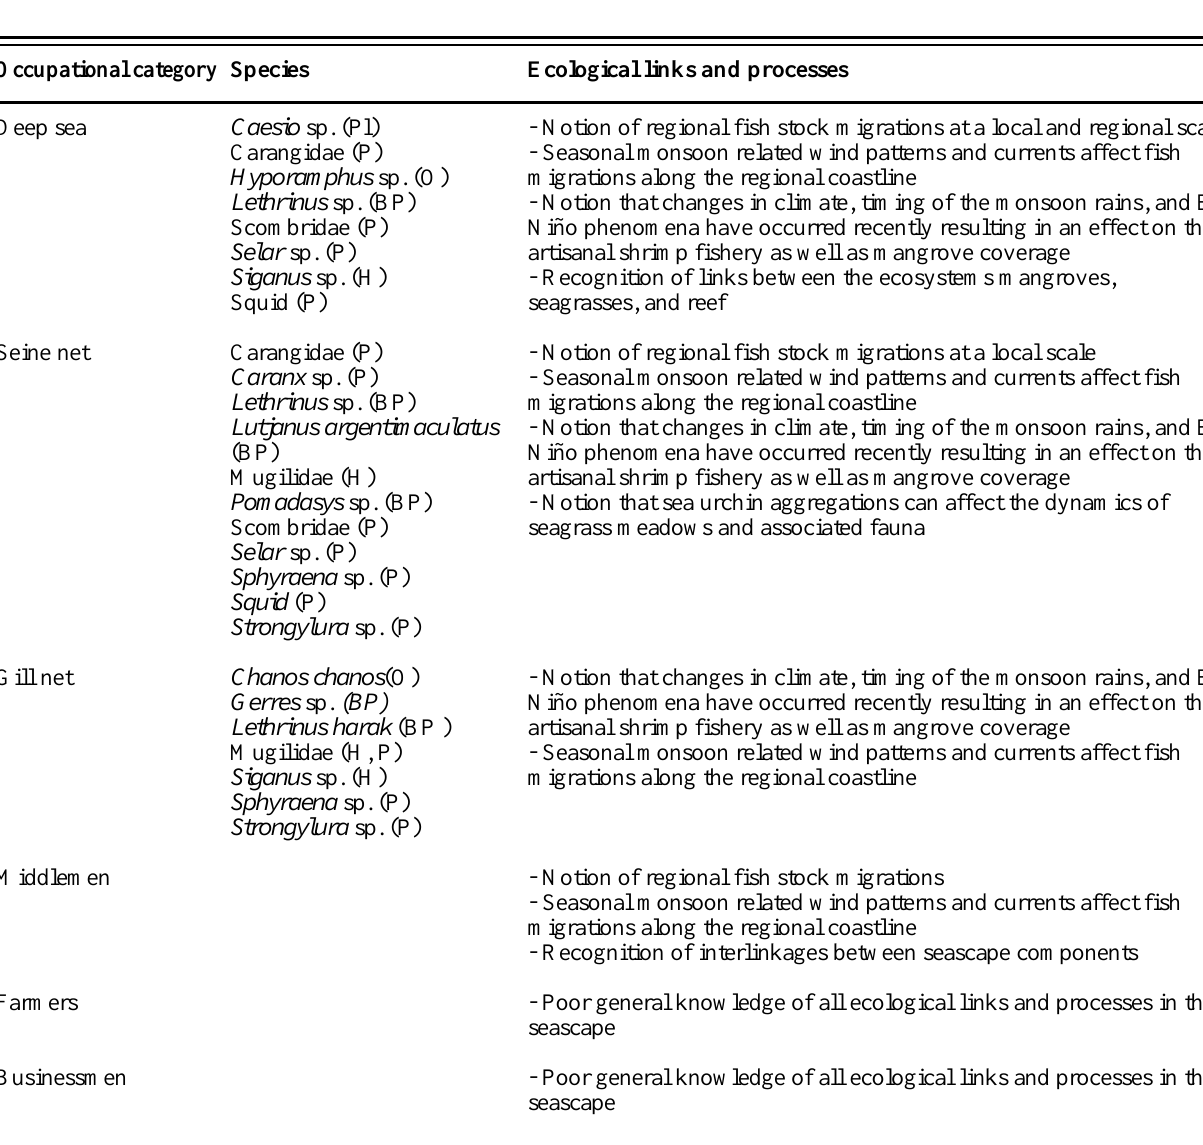
Table 5. Summary of local ecological knowledge of different occupational groups in the target community, Kenya. Species refer to marine species of fish and shellfish targeted by categories of fishermen. For each species the functional groups to which it belongs, based on trophic level, is indicated in brackets; Pelagic/ demersal predator, (P) Benthic predator, (BP) Herbivores, (H) Planktivores, (Pl) Omnivores